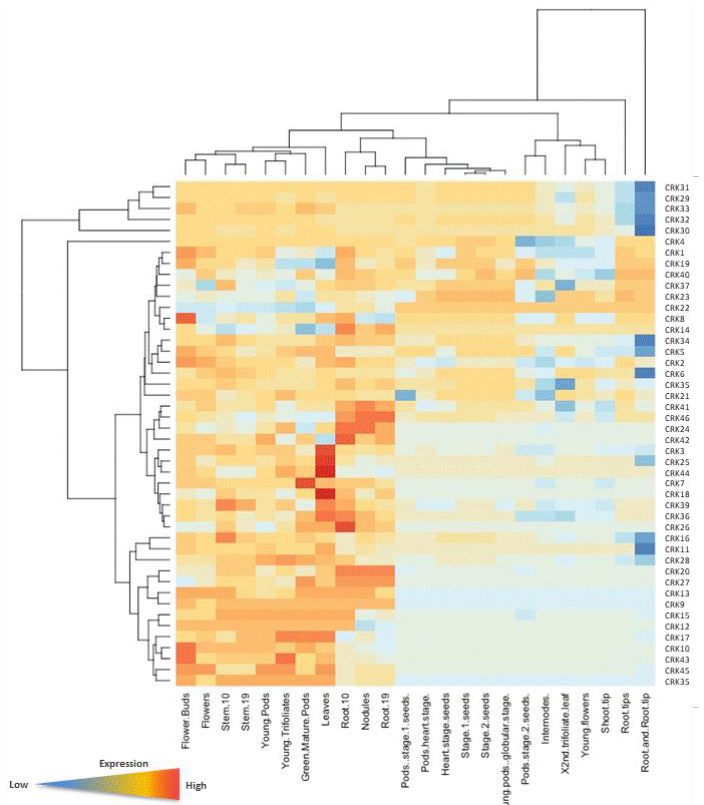
Figure 4. In silico expression profiles of P. vulgaris CRKs. Heat map expression profiles of CRK family genes in various tissues of P. vulgaris . The transcriptome data across different tissues were extracted by Phytozome ( P. vulgaris v2.1) and the P. vulgaris gene expression atlas (PvGEA). The heat map was generated by R using the Fragments per kilobase of exon model per million reads mapped (FPKM) values of each CRK gene.